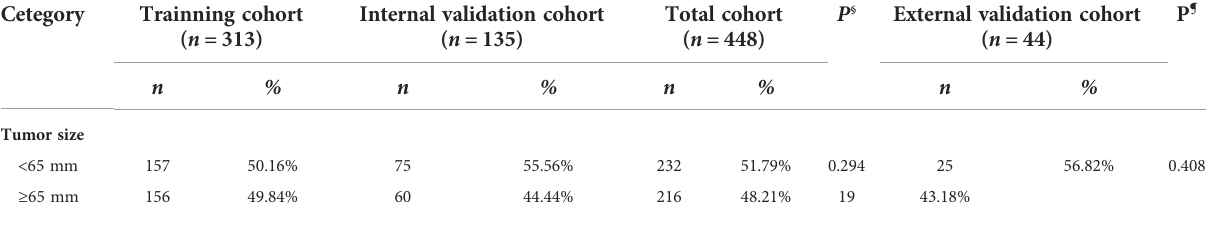
Figure 3. In Figure 3, the time-dependent AUC at each time point revealed that the nomogram had a higher AUC at all time